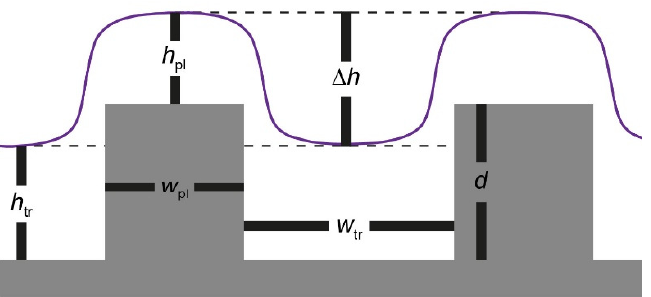
Figure 1. Illustration of the profile of a film coated on a topographic substrate showing the variables used in this study: local films thicknesses on the plateaus and in the trenches ( h pl and h tr , respectively), plateau and trench widths ( w pl and w tr , respectively), trench depth ( d ), and height contrast ( ∆ h ).